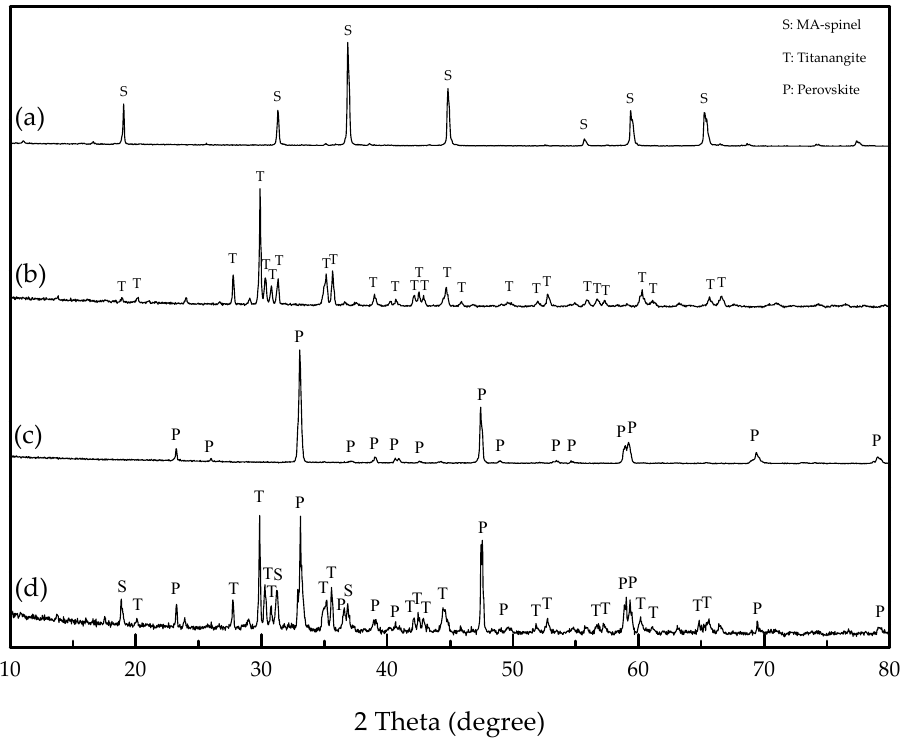
Figure 3. XRD spectra of the synthetic MA-spinel ( a ), titanaugite ( b ), perovskite ( c ), and modified slag ( d ).